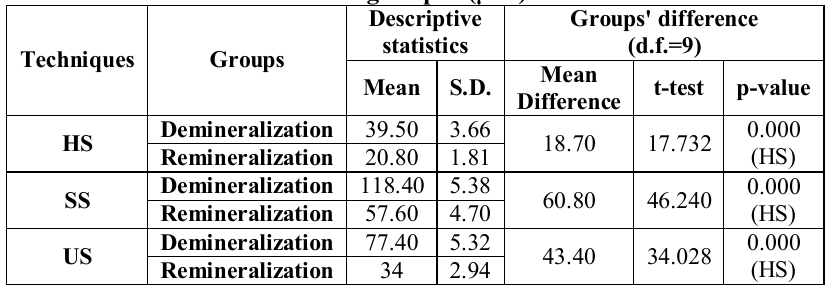
Table 3: Comparison between demineralization and re-mineralization groups of the enamel damage depth